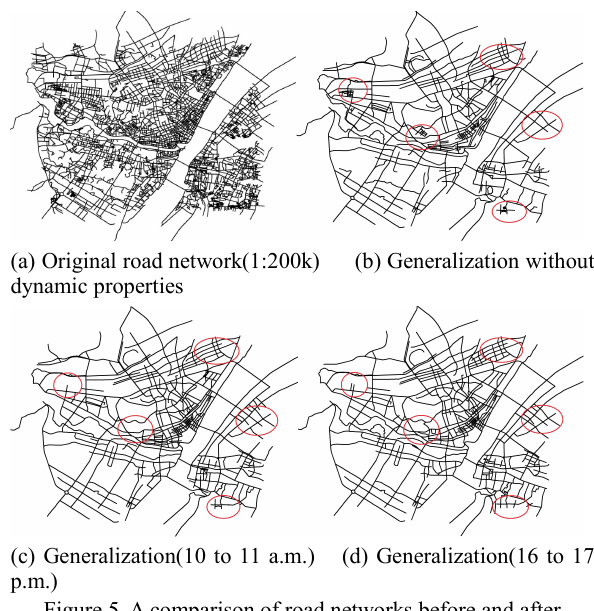
Figure 5. A comparison of road networks before and after generalization (scale 1:2000k)